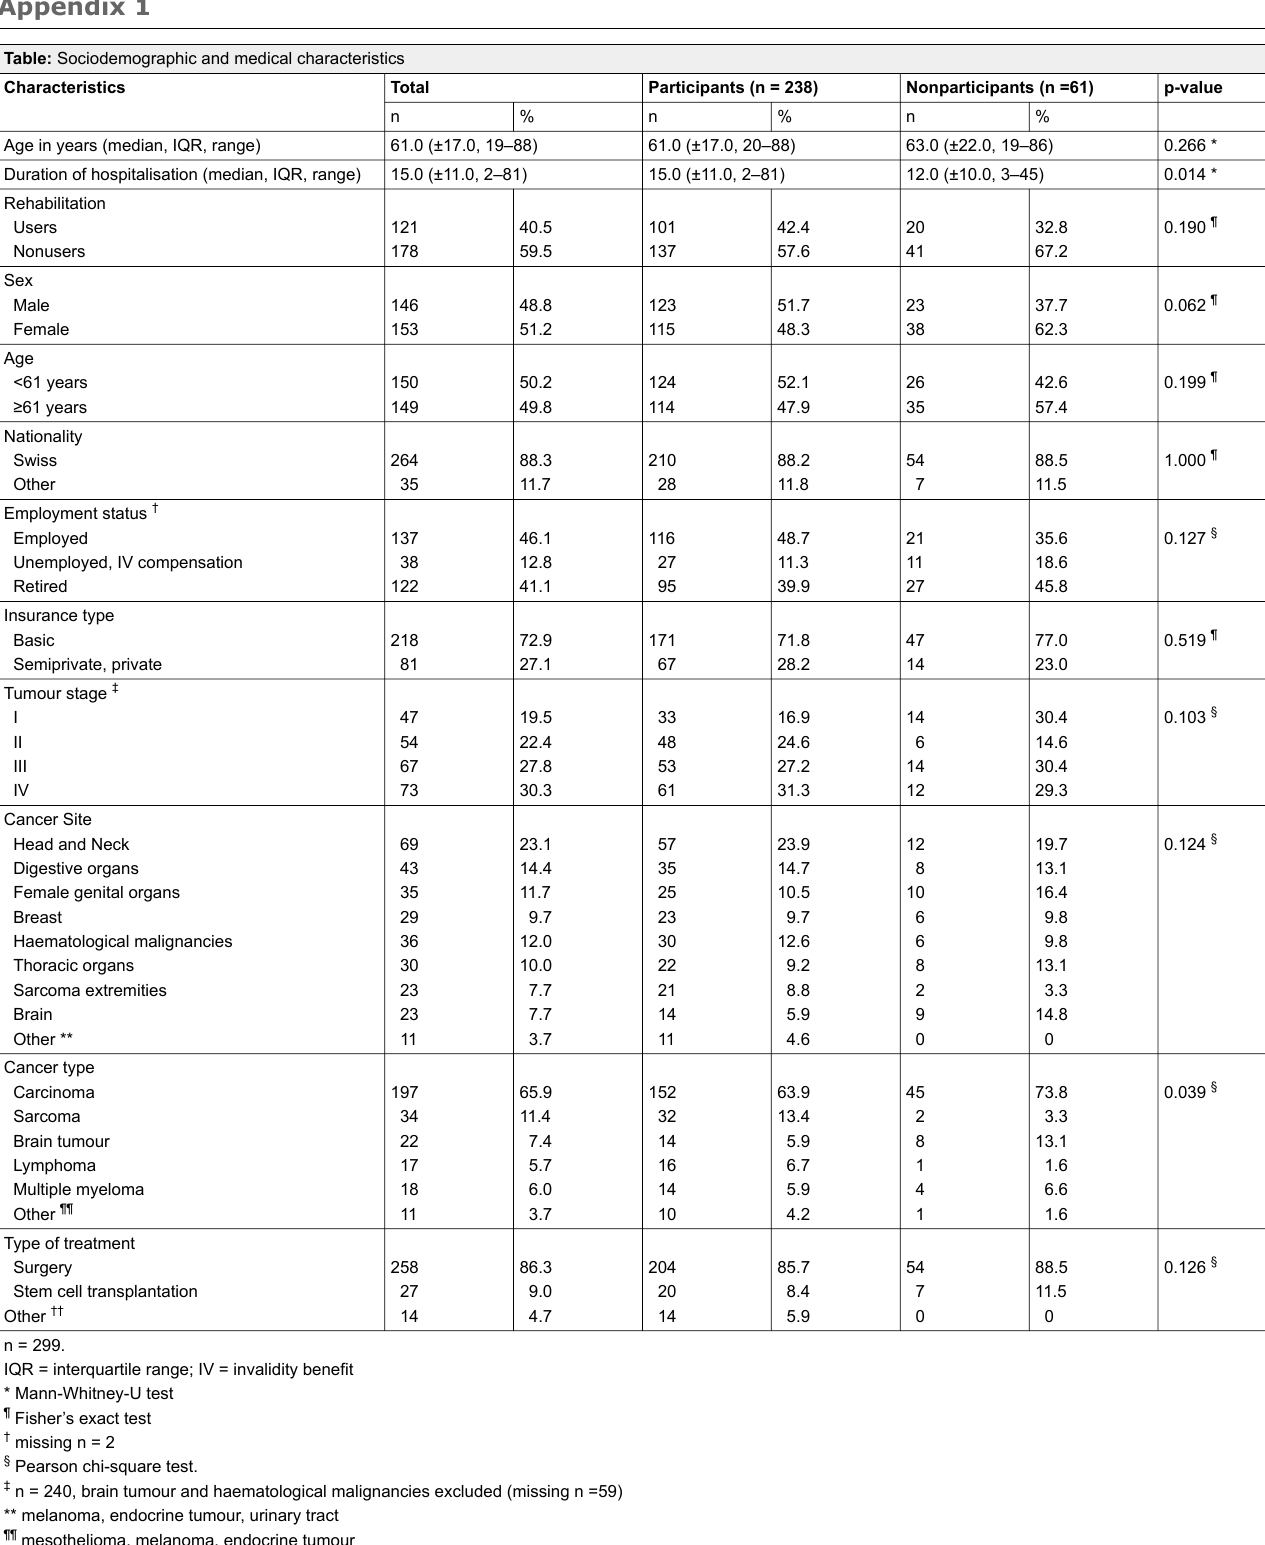
Table: Sociodemographic and medical